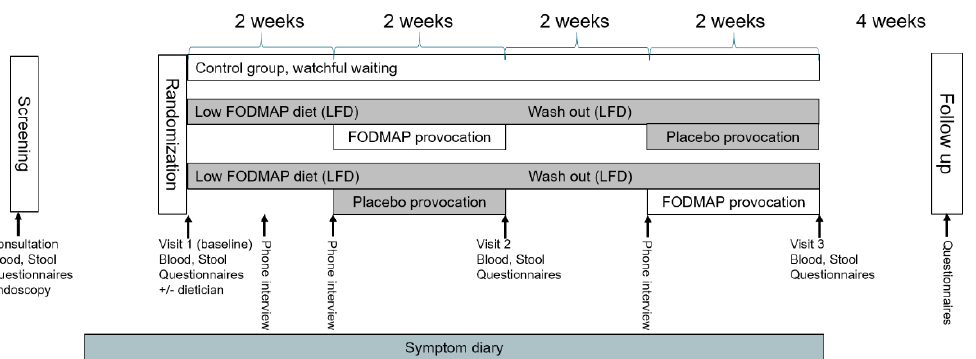
Figure 1. Figure 1 shows the protocol. After randomisation, 1/3 was a watchful waiting control group, and 2/3 of patients were placed on an open label low-FODMAP diet and provoked double-blinded with placebo and FODMAPs, respectively in a cross-over fashion. Between provocations there was a two-week low-FODMAP diet wash out. During the study, patients had three identical consultations with questionnaires, blood and stool sampling. A symptom diary was filled in daily throughout the entire study period.